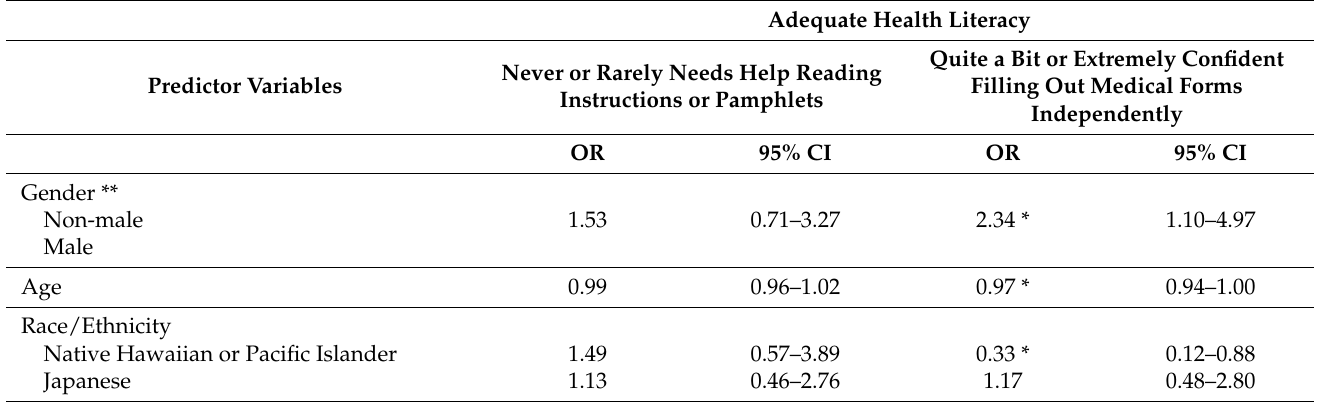
Table 3. Health Literacy Associations with Individual and Social